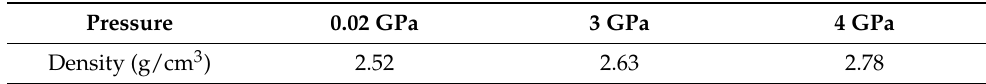
Table 2. Density of Al 2 O 3 /Al-20Si composite.